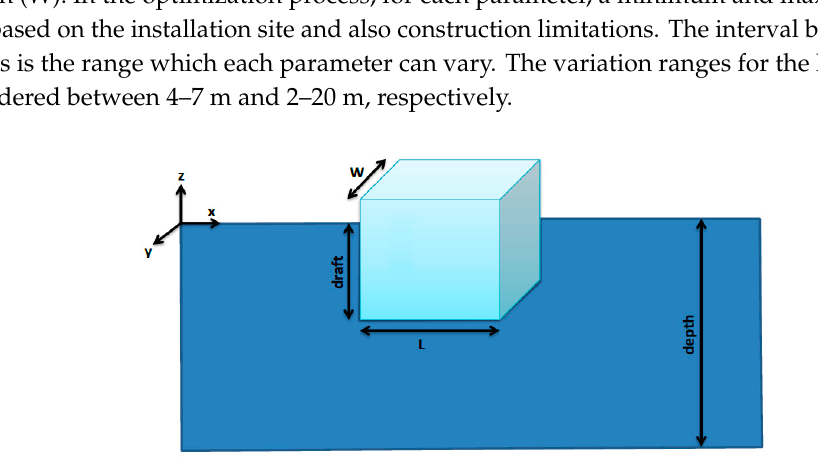
Figure 10. Optimization results of the parallelepipedic hull shape for length parameter.